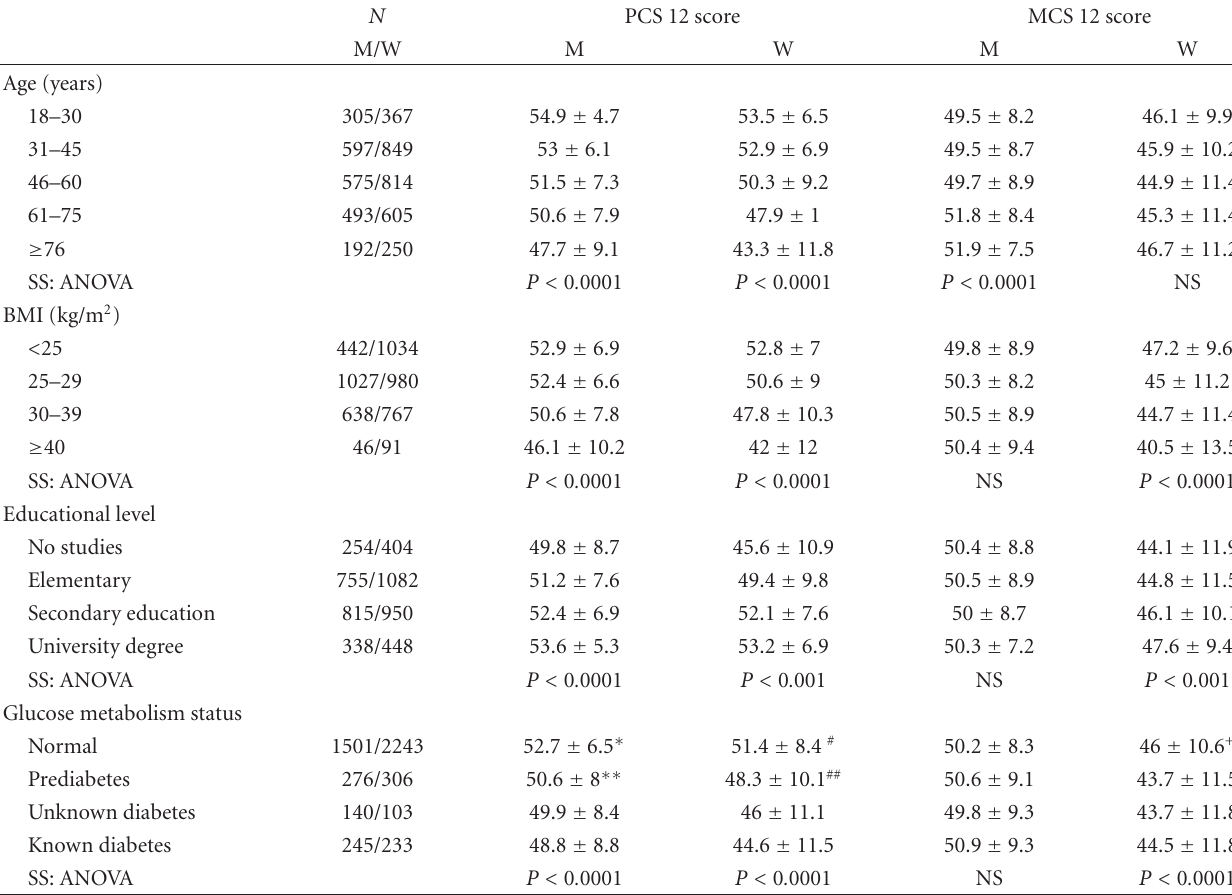
Table 1: PCS 12 and MCS 12 scores stratified by age, BMI, educational level, and glucose metabolism